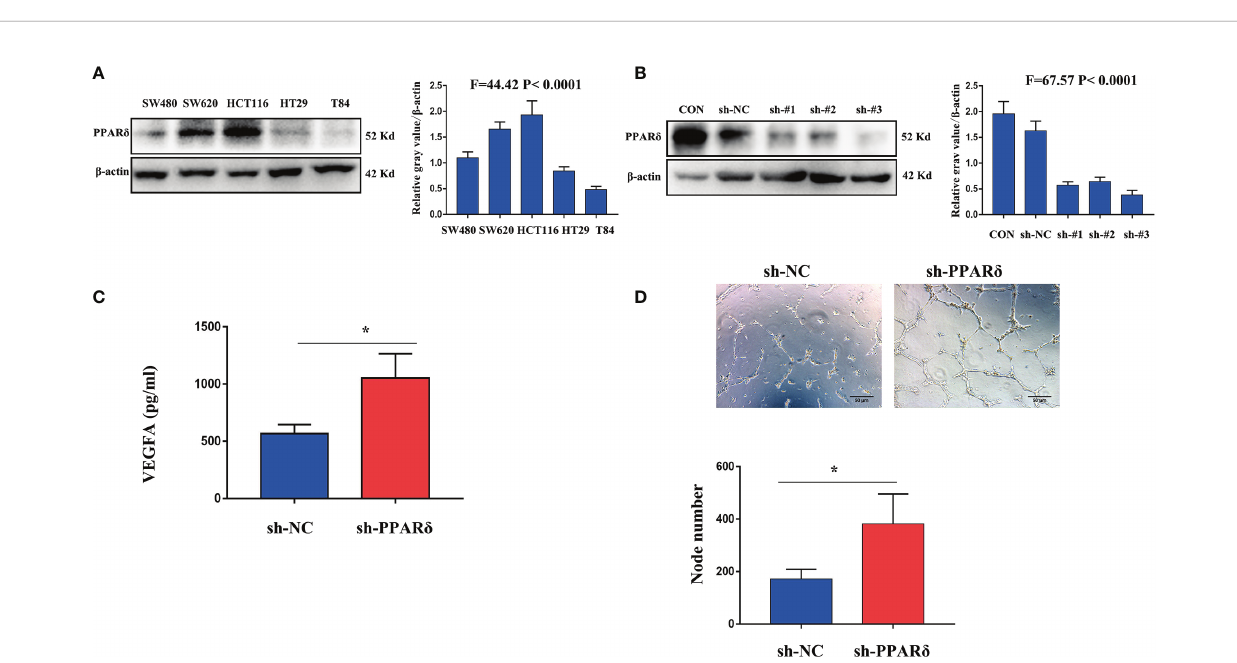
FIGURE 2 | KnockdownofPPAR d promotes HUVEC tube formationthroughVEGFA. (A) WesternblotanalysisofPPAR d expressionin fi vedifferentCRC celllines. (B) Veri fi cationofPPAR d knockdowninHCT116cellsbyWesternblotanalysis. (C) VEGFAsecretioninconditionedmediumofHCT116cellswasexaminedbyELISA. (D) HUVECtubeformationimagesinthe twogroups. Thenumberoftubesshows theangiogenesis abilityinallgroups. Scalebars, 50 m m (magni fi cation, 400×),*P ≤ 0.05.